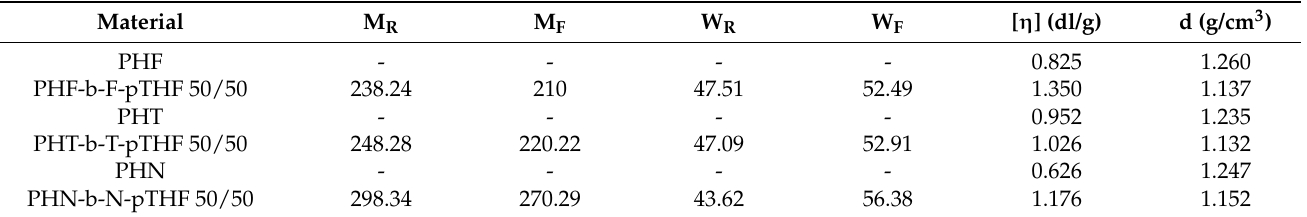
Table 3. Calculated composition and basic physico-chemical properties of synthesized polymers.